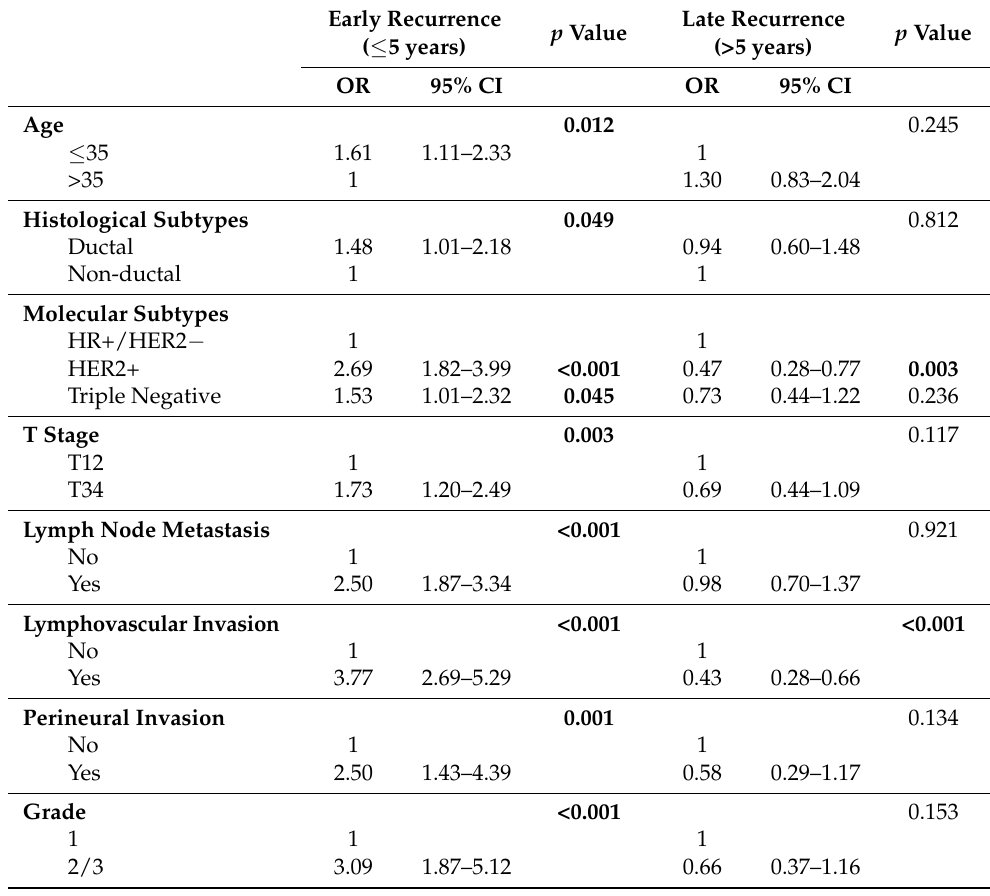
Table 2. Univariate analysis of risk factors for early and late